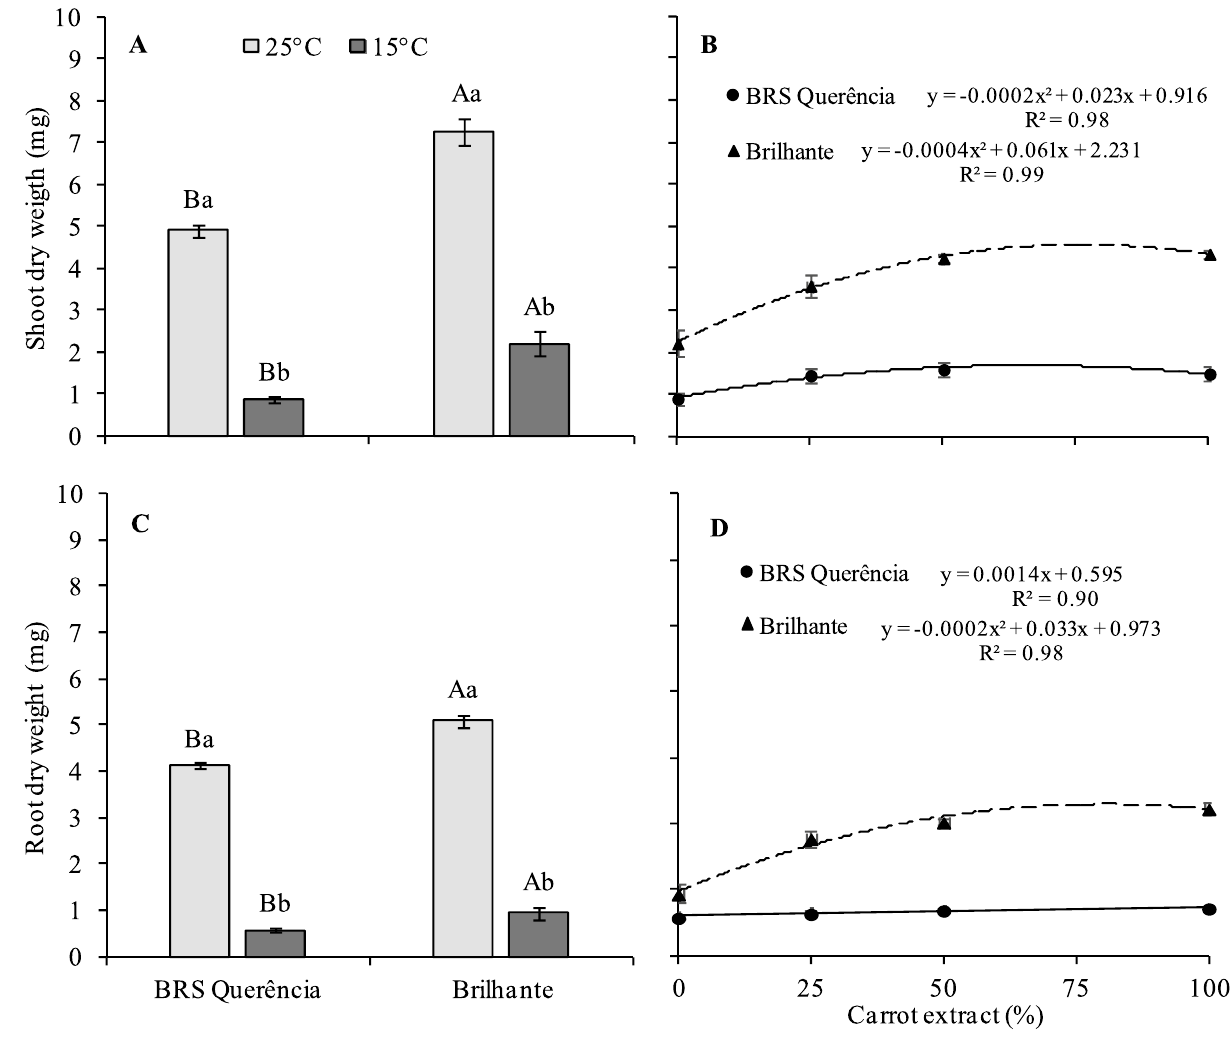
Figure 2. Shoot dry mass of controls (A) , shoot dry mass of treatments germinated at 15 °C (B) , root dry mass of controls (C) and root dry mass of treatments germinated at 15 °C (D) of rice seedlings of cultivars BRS Querência (filled circle) and Brilhante (filled triangle). Means followed by the same letter, upper case in the comparison of the cultivars and lower case in temperatures, do not differ by Tukey’s test (P ≤ 0.05). Bars represent the standard error of the mean of four replicates.